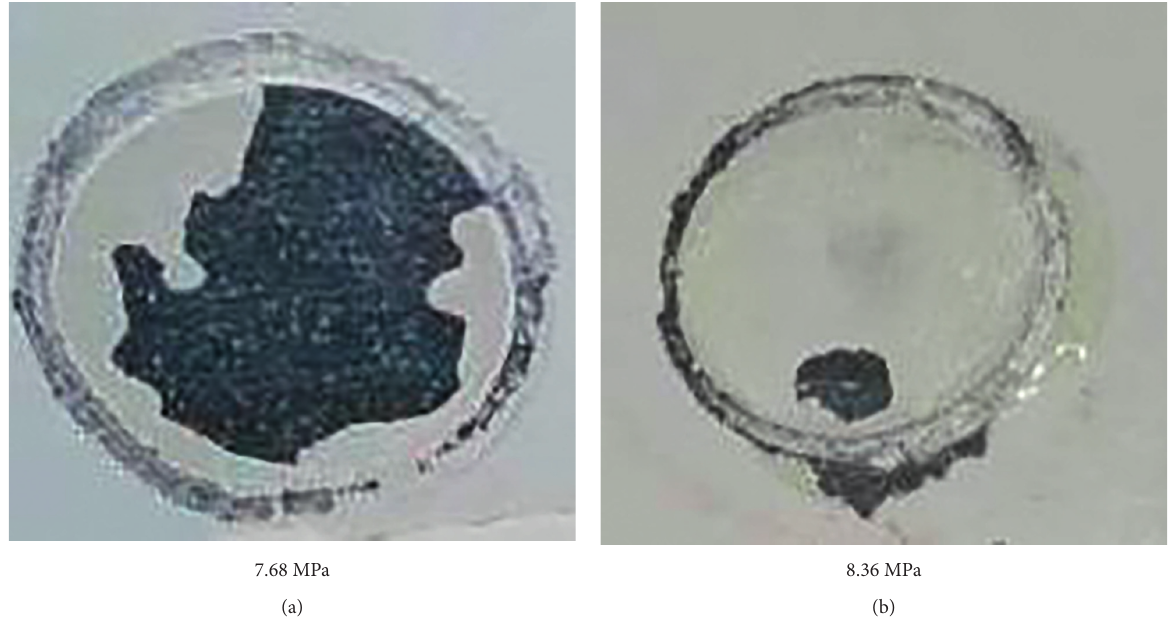
Figure 21: The paint of the specimens after tensile tests. (a) The paint of the specimen after the manual grinding process. (b) The paint of the specimen after sandblasting